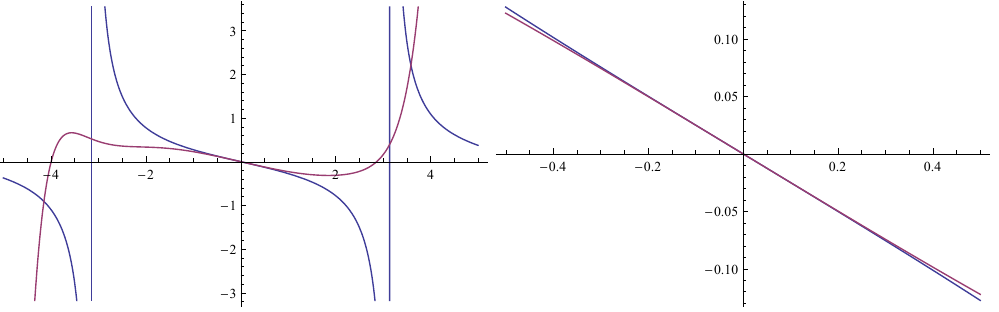
Figure 13. Exact and approximate of Equations (104) and (91) when { x , − 5,5 } and { x , − 0.5,0.5 }